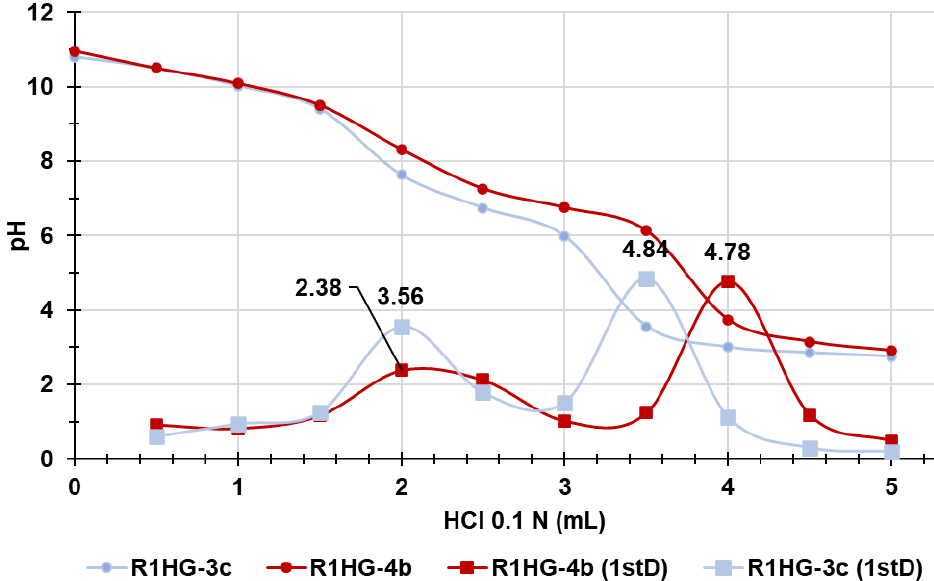
Figure 14. Potentiometric titration of R1HG-3c and R1HG-4b (lines with round indicators); first derivatives (dpH/dV) of the titration curves (lines with square indicators). Error bars knowingly omitted to not complicate the image.